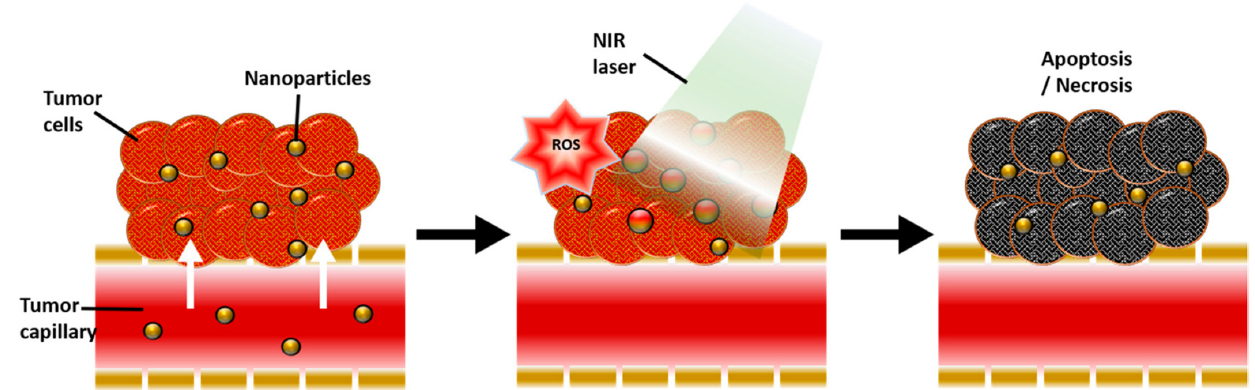
Figure 5. Schematic diagram showing the physiological and biological effects of gold nanoparticle- mediated photothermal therapy (PTT) and photodynamic therapy (PDT). A large amount of gold nanoparticles accumulate due to the leaky vasculature of the tumour, resulting in a photothermal effect in response to near-infrared (NIR) light and reactive oxygen species (ROS) generated by secondary delivered photosensitizer (PS), ultimately inducing apoptosis and necrosis of tumour tissue. Reproduced with permission from [74]. Copyright Kim et al. 2018.